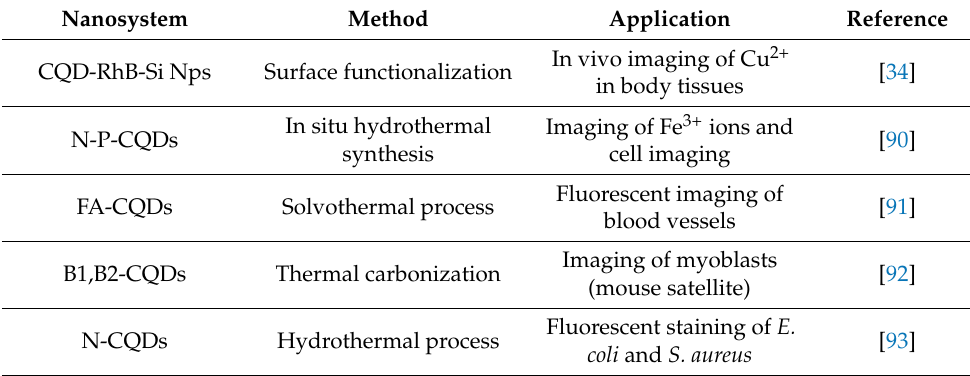
Table 4. Recent developments in CQDs-based bioimaging